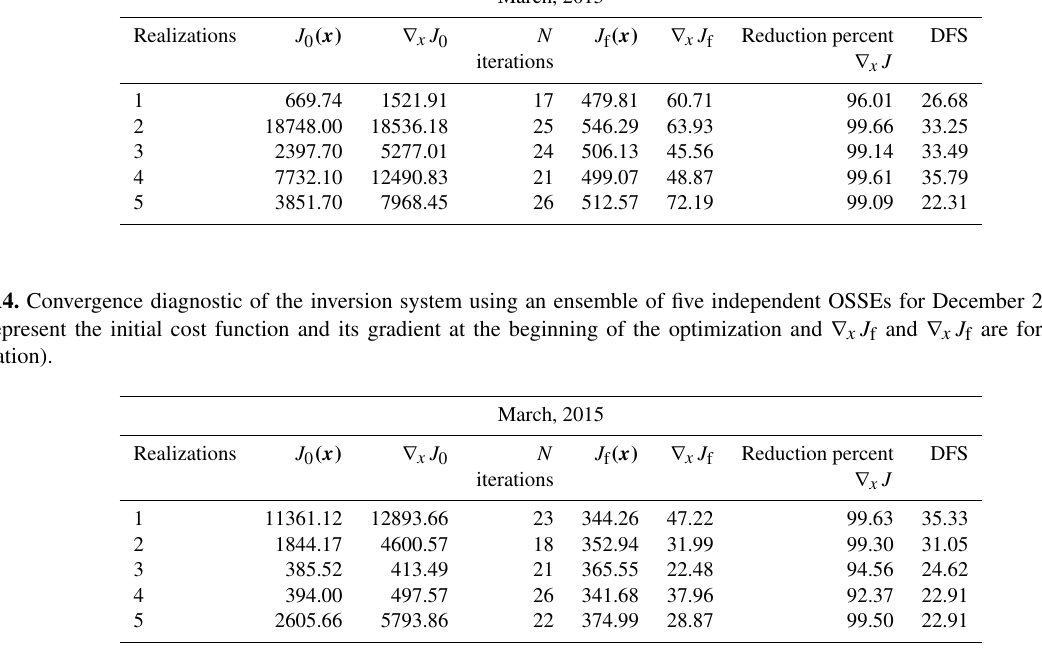
∇ x J ∇ x J f and f are for the end).